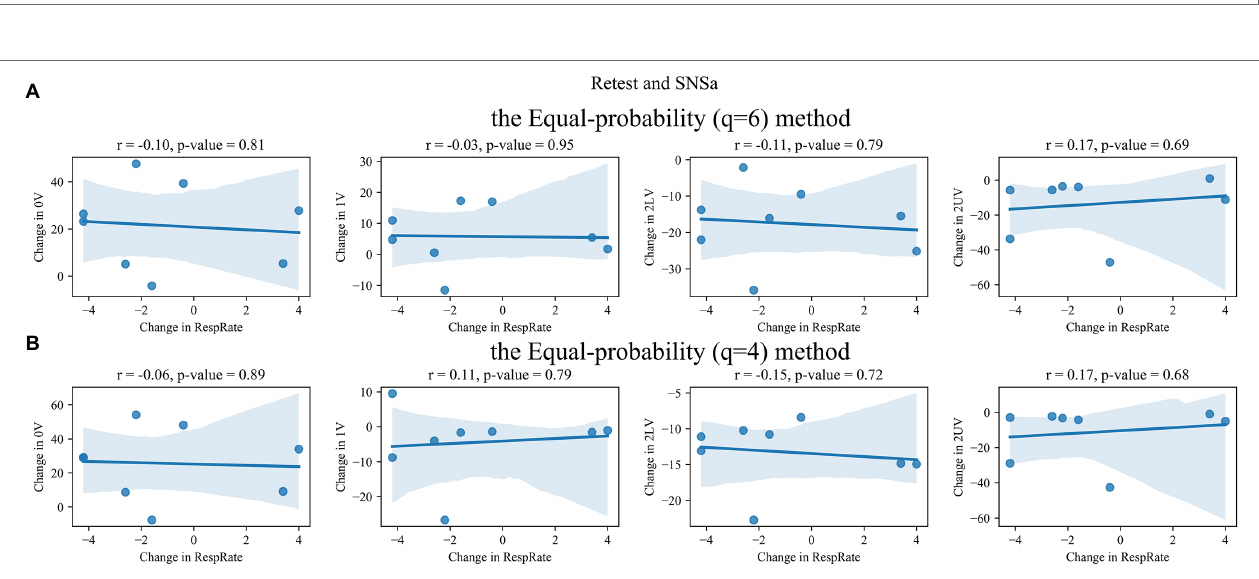
FIGURE 8 | Correlation between SNSa stimulation–retest differences in SymDyn indices and differences in respiratory rate (RespRate): (A) the Max–min method, (B) the σ